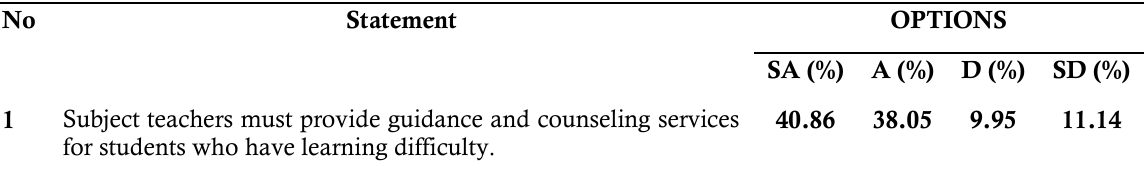
Table 3. Subject teachers must provide Guidance and Counseling services to students who have learning